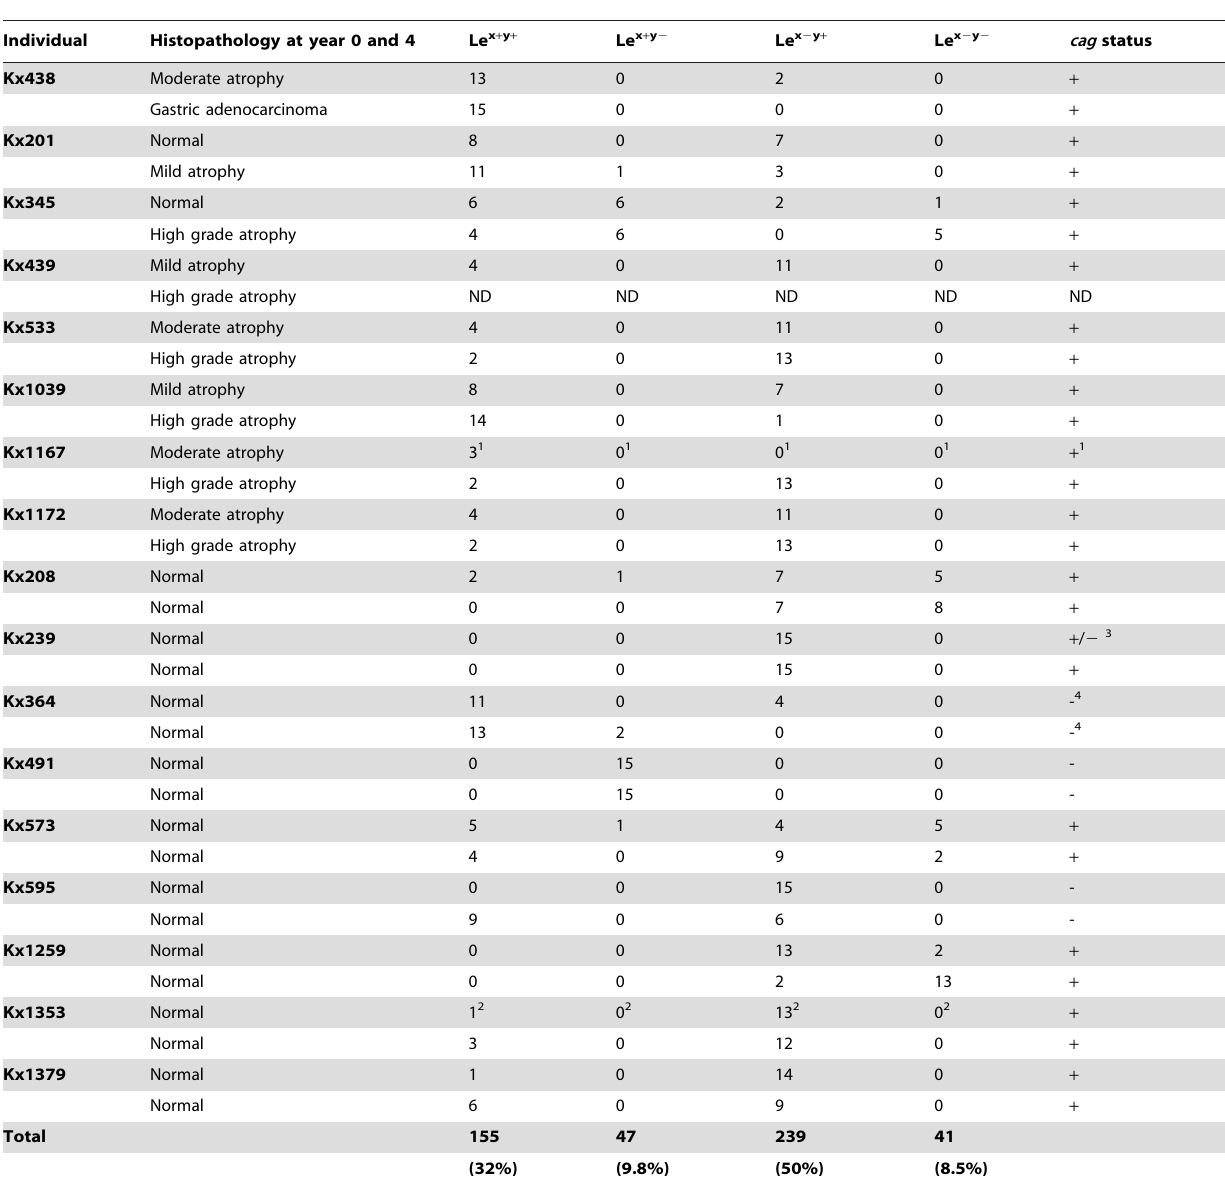
Table 2. Lewis phenotypes and cag status of clinical H. pylori isolates obtained from the Kalixanda study.